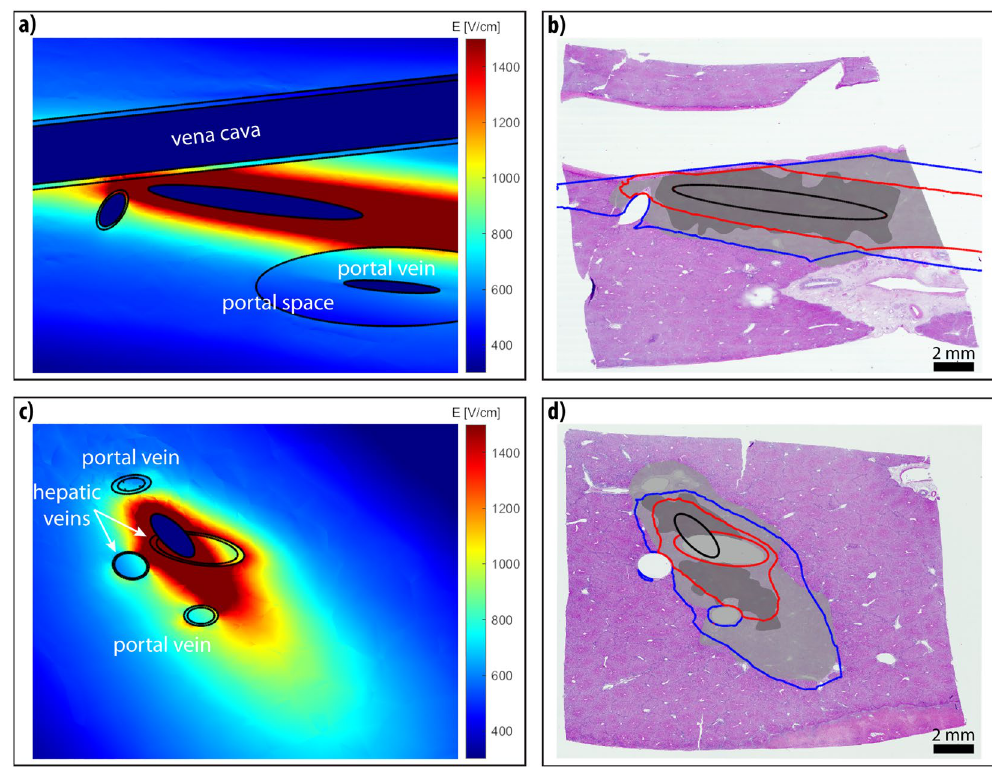
Figure 2. Reconstruction results of cases S3 ( a , b ) and S4 ( c , d ) with linear geometry electrodes. ( a , c ) Computed electric field distribution in a slice of the 3D model, corresponding to the microscopic image. Geometric entities are outlined in black. ( b , d ) Segmented Zone A (dark grey) and Zone B (light gray), and computed Zone A (red contour) and Zone B (blue contour) shown as an overlay on the microscopic image of the treated area.